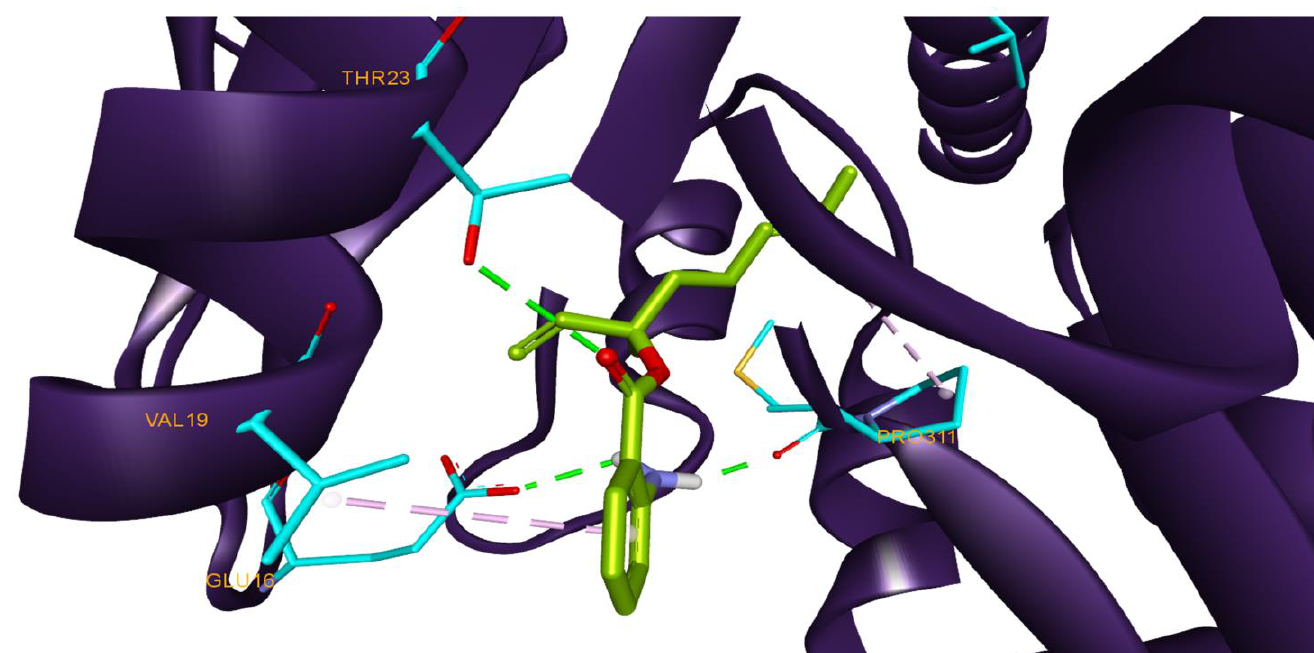
Figure 3. The structure of DDl (2I80) in complex with docked compound 24 (linalyl anthranilate) interacting with highlighted amino acids (cyan) Val19, Glu16, Pro311 and Thr23; HB interactions are depicted as green dotted lines and hydrophobic interactions as purple dotted lines.